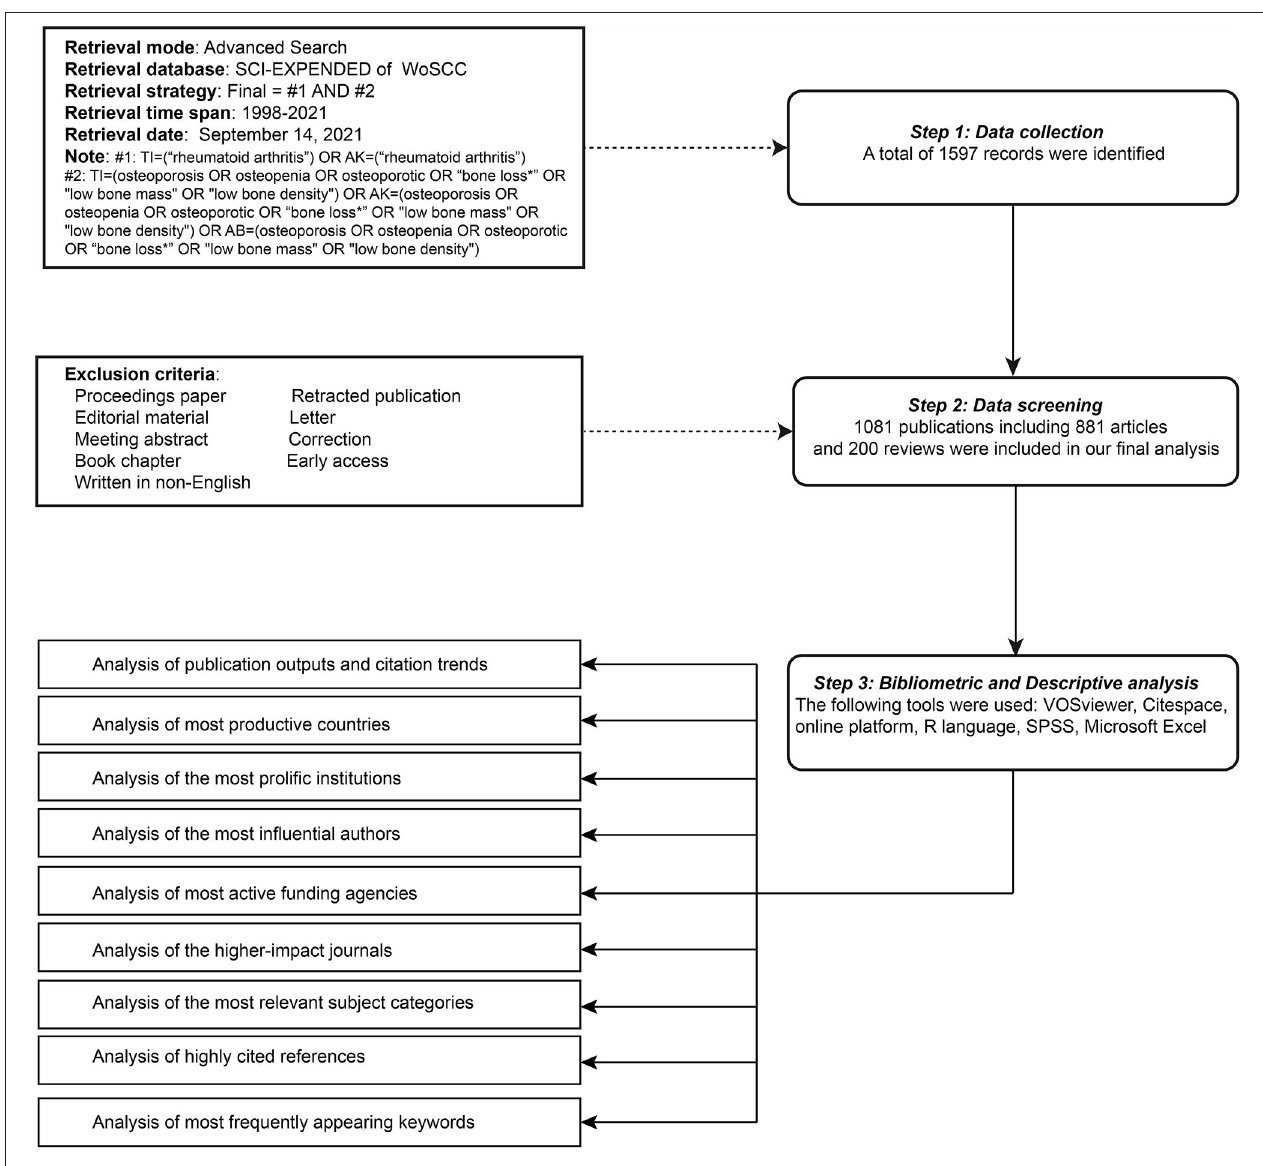
FIGURE 1 | Flowchart of literature selection and data